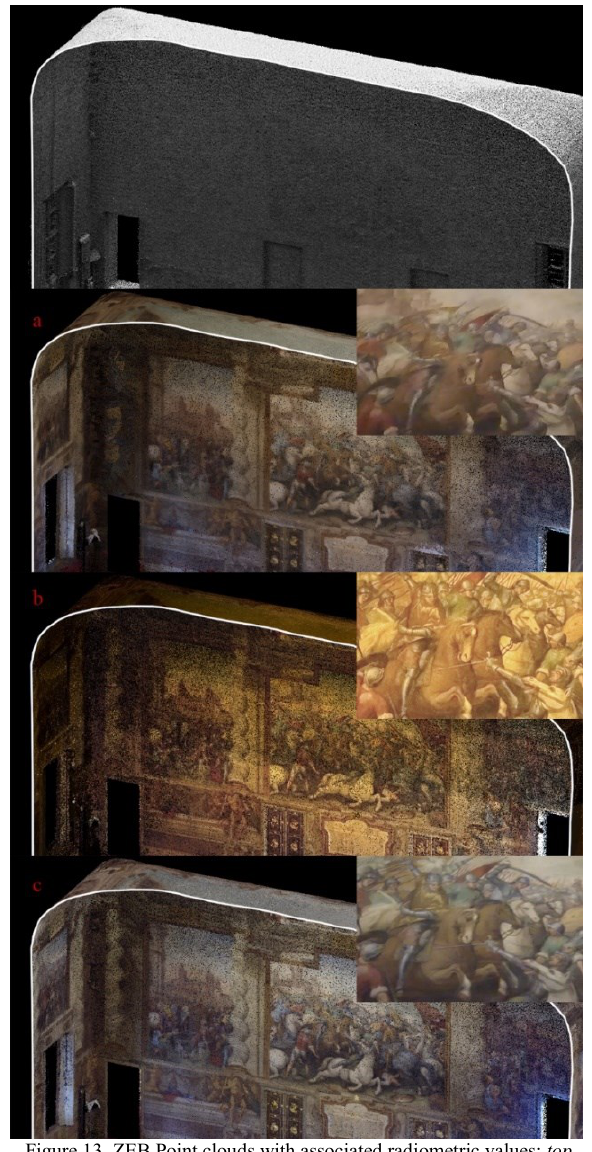
Figure 13. ZEB Point clouds with associated radiometric values: top , ZEB point cloud in shaded view. Photogrammetric point clouds: a , ZEBcam; b , Sony ILCE; c , steadicamera. For each point cloud model, a zoomed view of the image used in the photogrammetric process.